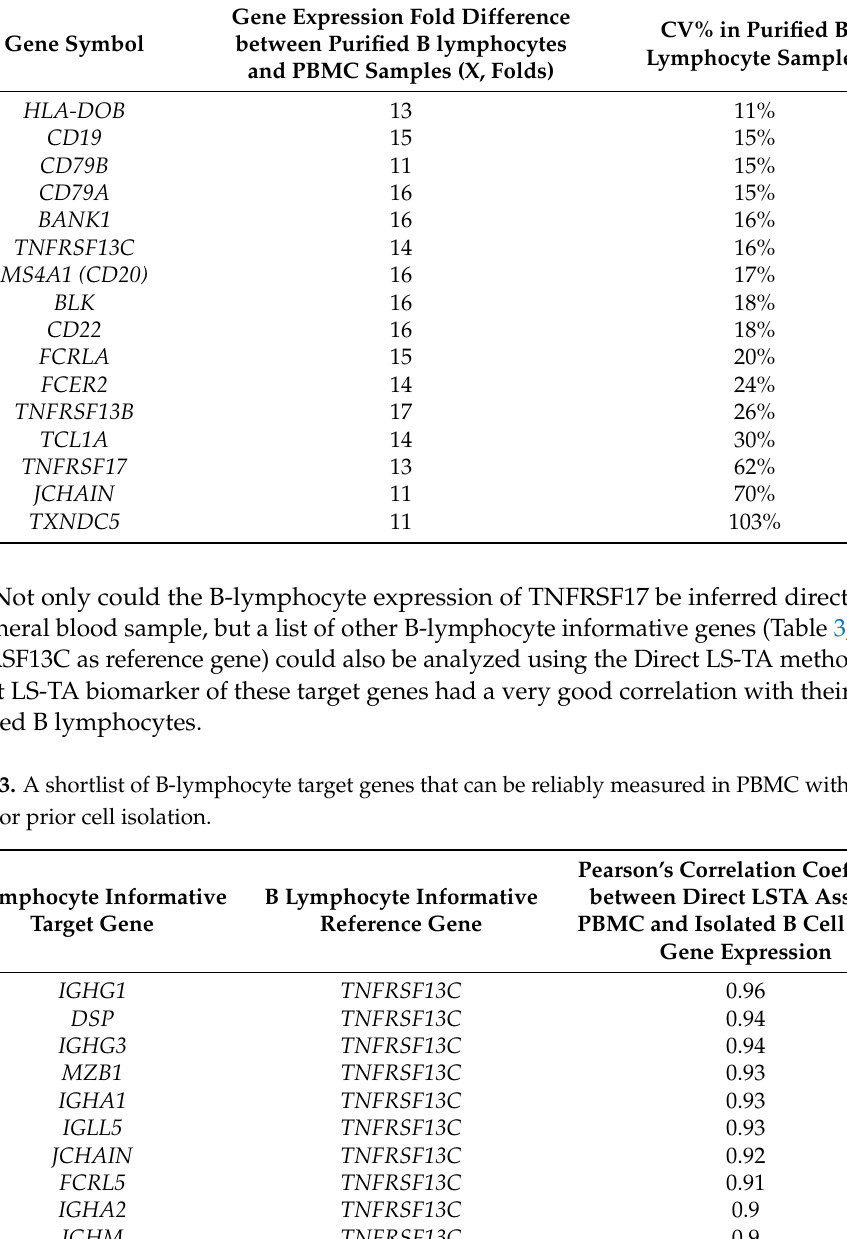
Table 2. Shortlisted potential B lymphocyte informative genes in RNAseq dataset GSE45764. Cell- type informative reference genes could be selected among those with low CV%. Two genes stand out among peers of other well-recognized B cell markers: TNFRSF13C and FCRLA, which were further analyzed as B cell informative reference genes for this manuscript. (Both TNFRSF13C and FCRLA used as reference gene in the meta-analyses of Direct LS-TA biomarkers are shown in bold font). Gene Expression Fold Difference CV% in Purified B Gene Symbol between Purified B lymphocytes Lymphocyte Samples and PBMC Samples (X, Folds)